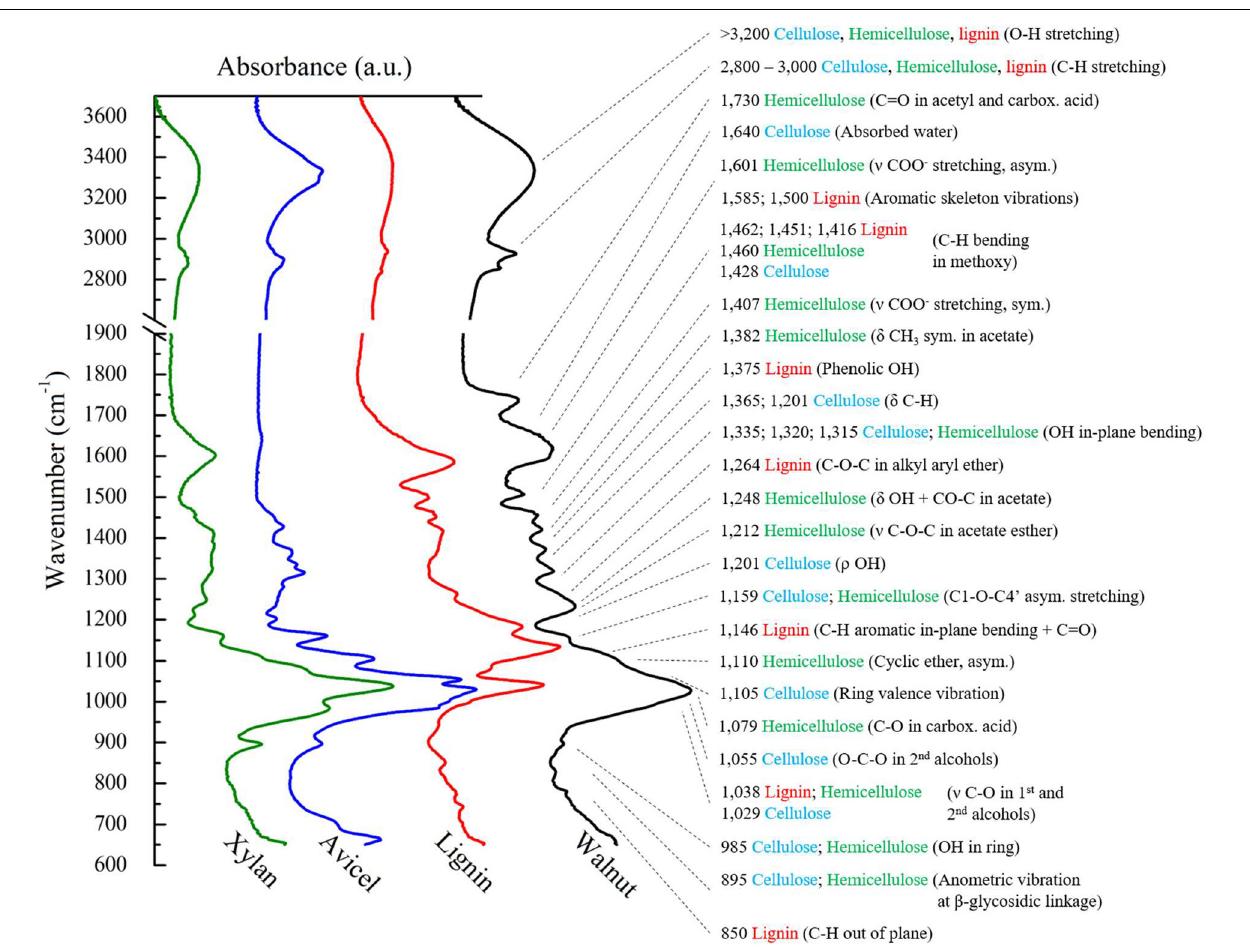
FIGURE 7 | FTIR spectra of raw walnut, cellulose, hemicellulose and lignin along with peak information. The spectral assignment was based on Zhao et al. (2014); Lv et al. (2015), Rashid et al. (2016); Horikawa et al. (2019), and Silva et al. (2019).